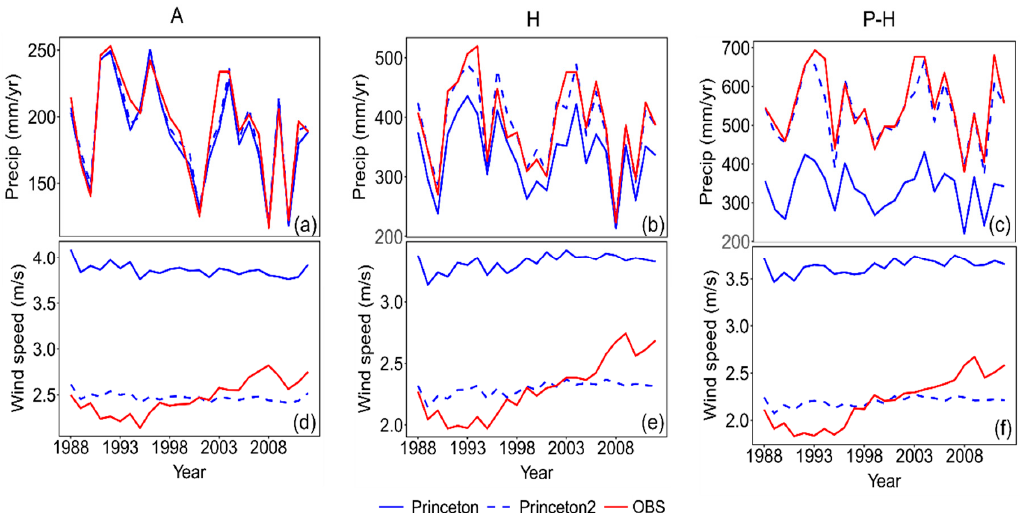
Figure 6. Pre ‐ and post ‐ adjusted time series of ( a – c ) areal average annual precipitation and ( d – f ) wind speed for the three climate zones Arid (A), Humid (H), and Per ‐ Humid (P ‐ H) from 1988 to 2012 for Princeton. The solid blue line represents the original gridded data, the dashed blue line represents the adjusted gridded data, while the solid red line represents interpolated station data (OBS).